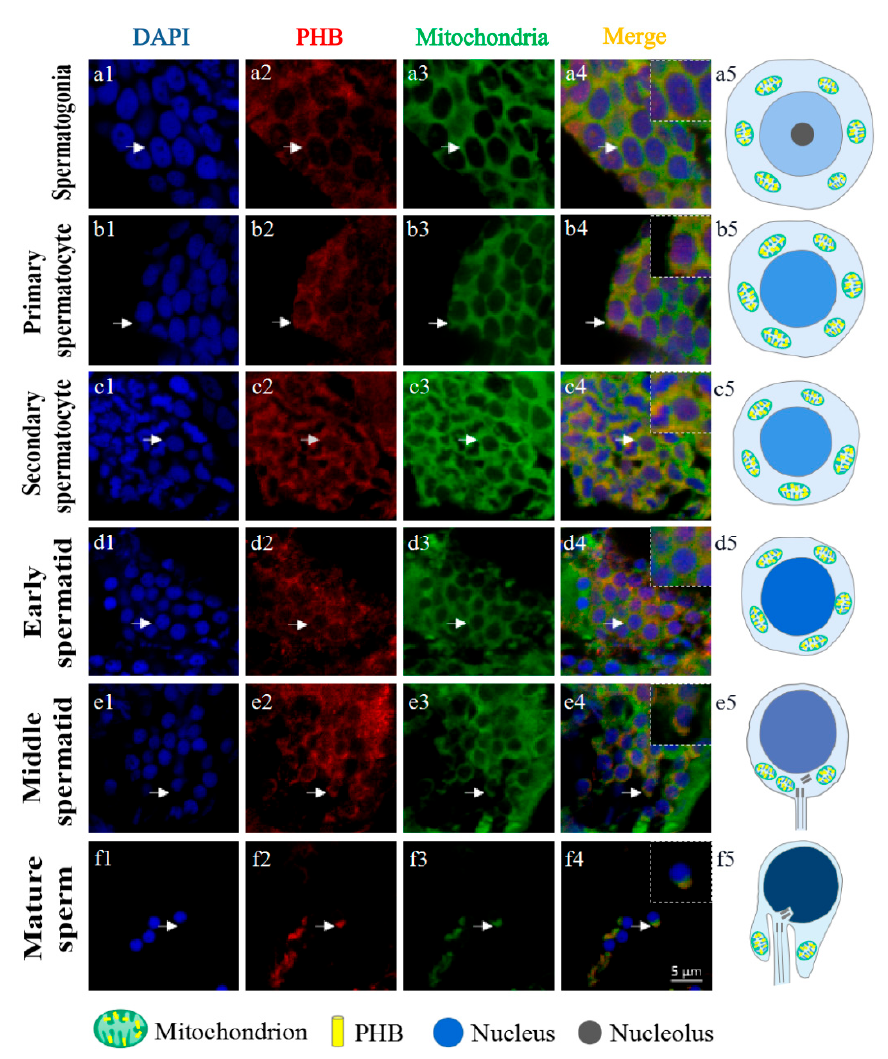
Figure 9. Immunofluorescence showed the distribution pattern of Ob -PHB and mitochondria during spermatogenesis. ( a5 , b5 , c5 , d5 , e5 ) PHB and mitochondria distribution in different spermatogenic cells. In spermatogonia, spermatocytes and early spermatids ( a1 – c5 ), Ob -PHB and mitochondria signals were evenly distributed in the cytoplasm around the nuclei; in middle spermatids, signals shift to the tail region ( d1 – d5 ). In mature sperm, signals aggregated in the midpiece ( e1 – e5 ). White arrows refer to the colocalization signal of Ob -PHB and mitochondria. At the mature sperm stage, Ob -PHB and mitochondrial signals were only detected in the midpiece ( f1 – f5 ).